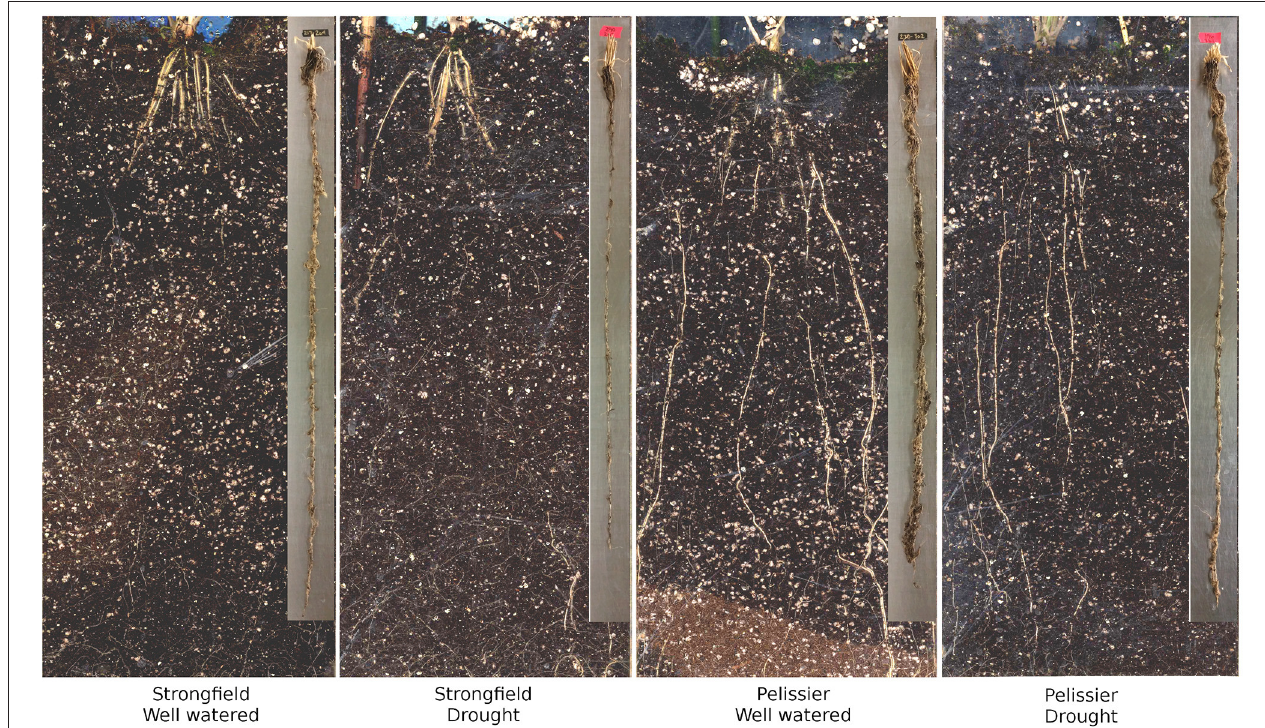
FIGURE 1 | Root distribution of Strongfield and Pelissier under well-watered and drought stress conditions in root boxes as described in Methods. The original has been digitally enhanced for brightness and contrast. Retrieved and washed roots of Strongfield and Pelissier are shown in the inset.